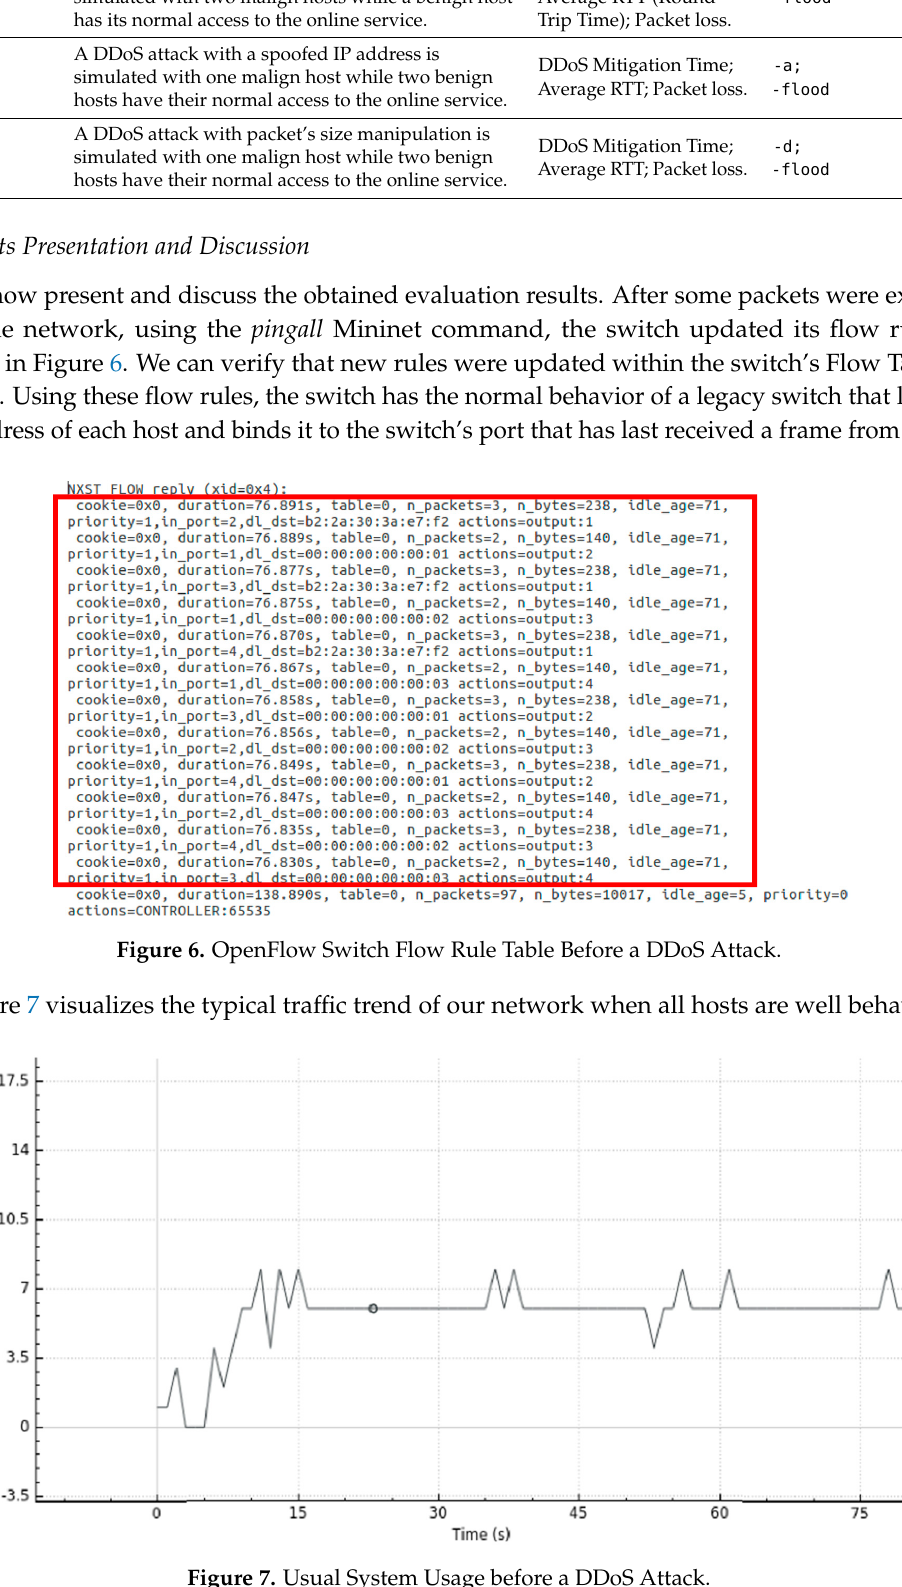
Figure 7. Usual System Usage before a DDoS Attack.